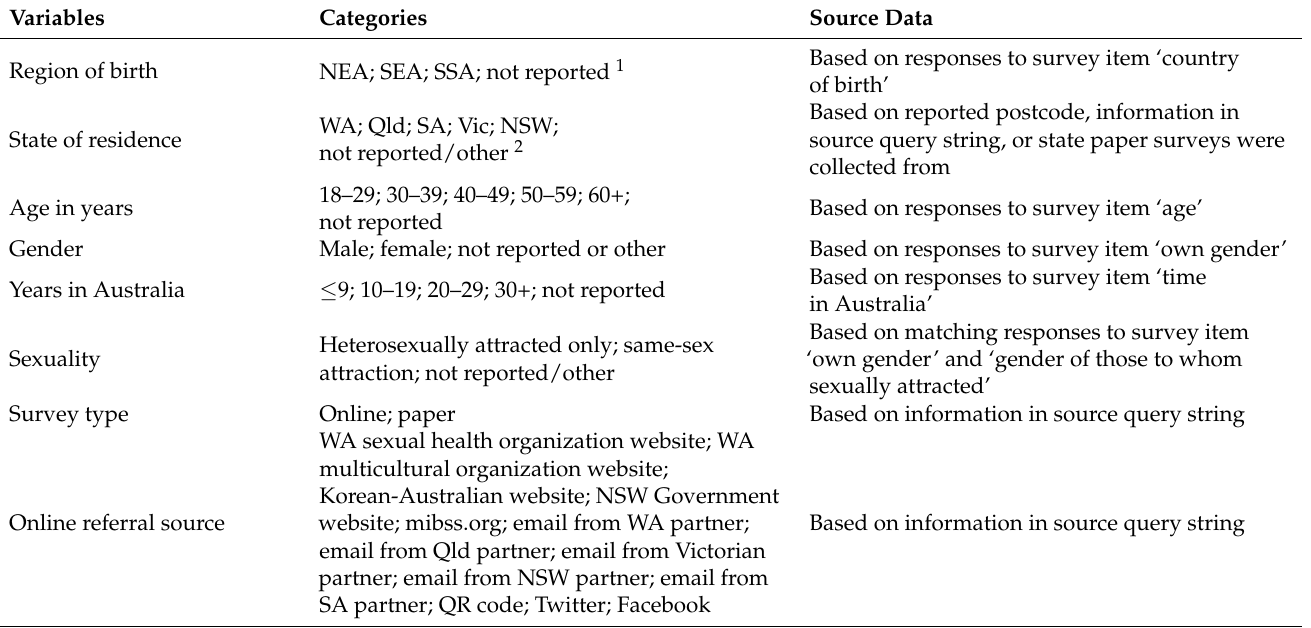
Table 2. Summary of variables used in statistical